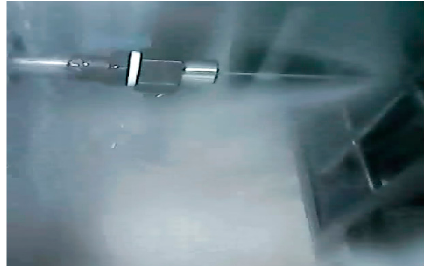
Figure 10. The initial stage of the oil shale breaking.